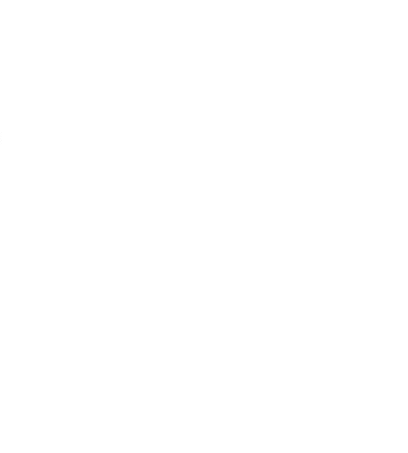
Figure 3. ORTEP diagram (50% probability ellipsoids) of complexes Ru16 . Hydrogen atom omitted for clarity.